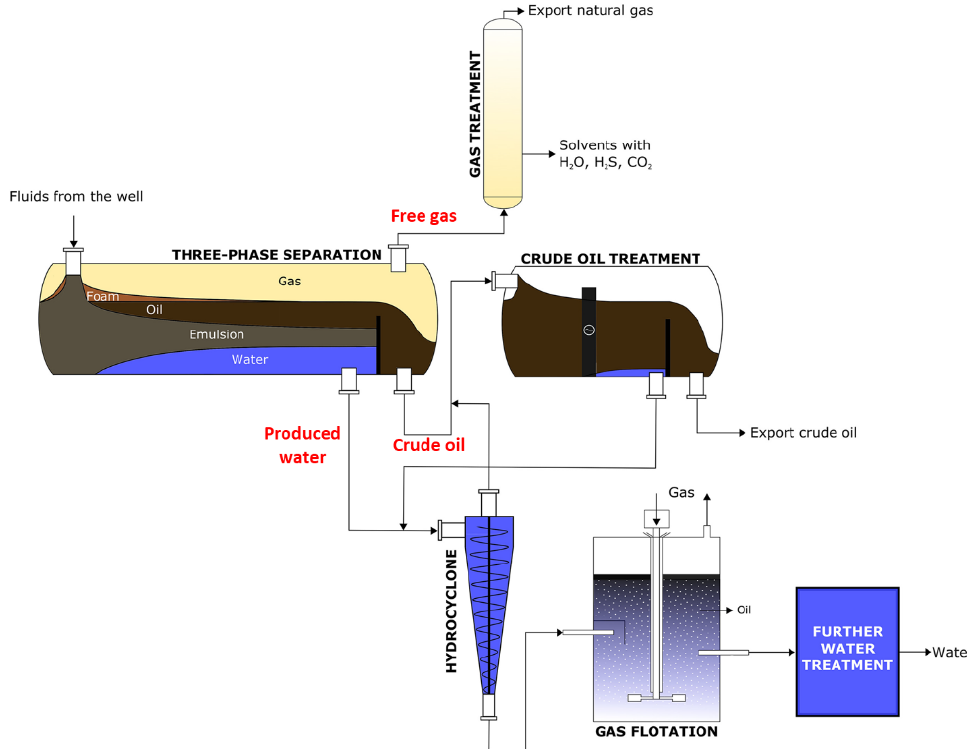
Figure 16. Schematic of an offshore crude oil, natural gas and water processing [197]. Reproduced with permission of Dudek et al., 2020 (ref. [197]). Copyright 2020 Elsevier B.V.